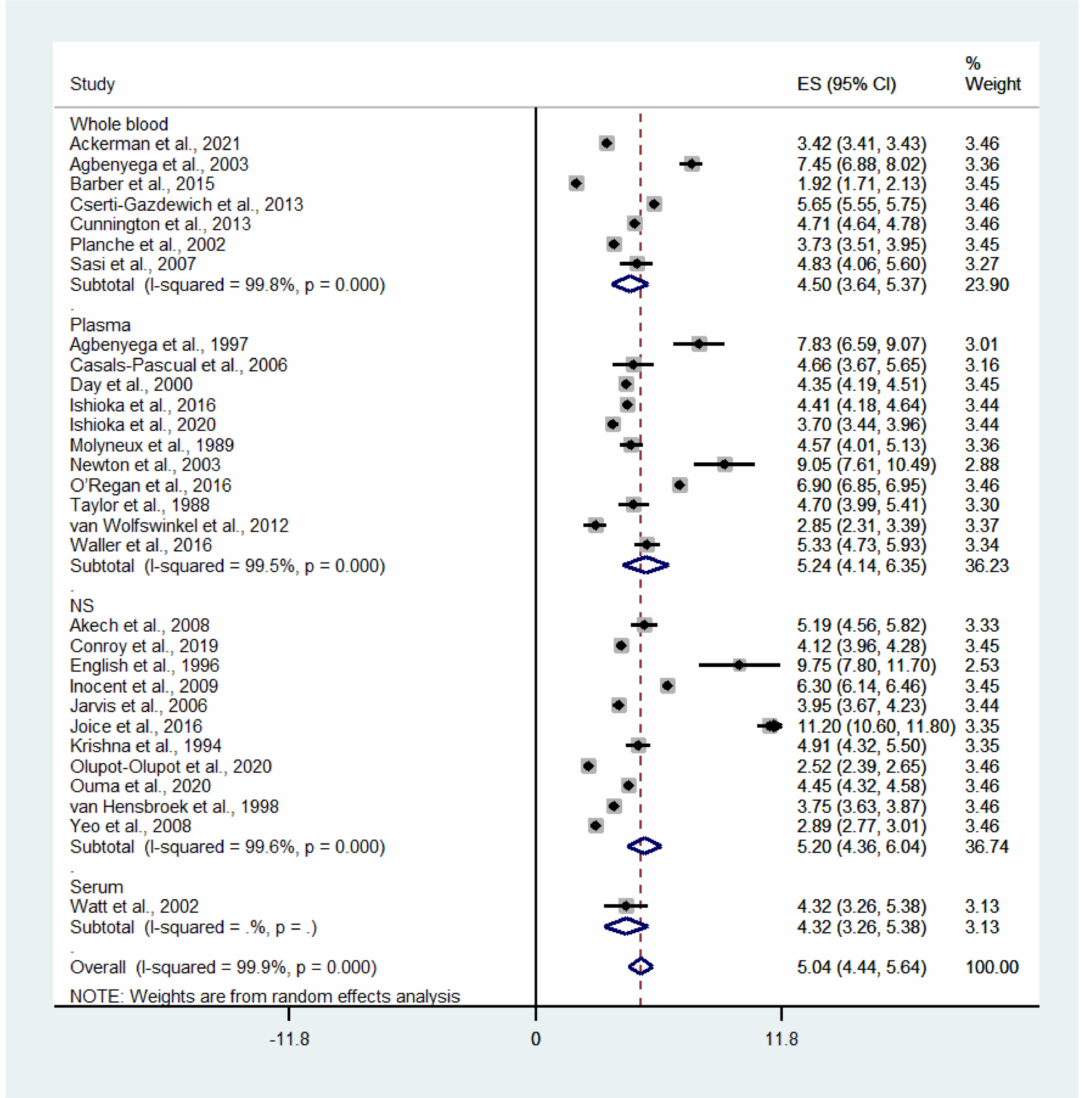
Figure 3. Mean lactate level in patients with severe malaria according to the type of blood sample used. Abbreviations: ES, estimated mean lactate; CI: confidence interval; NS, not